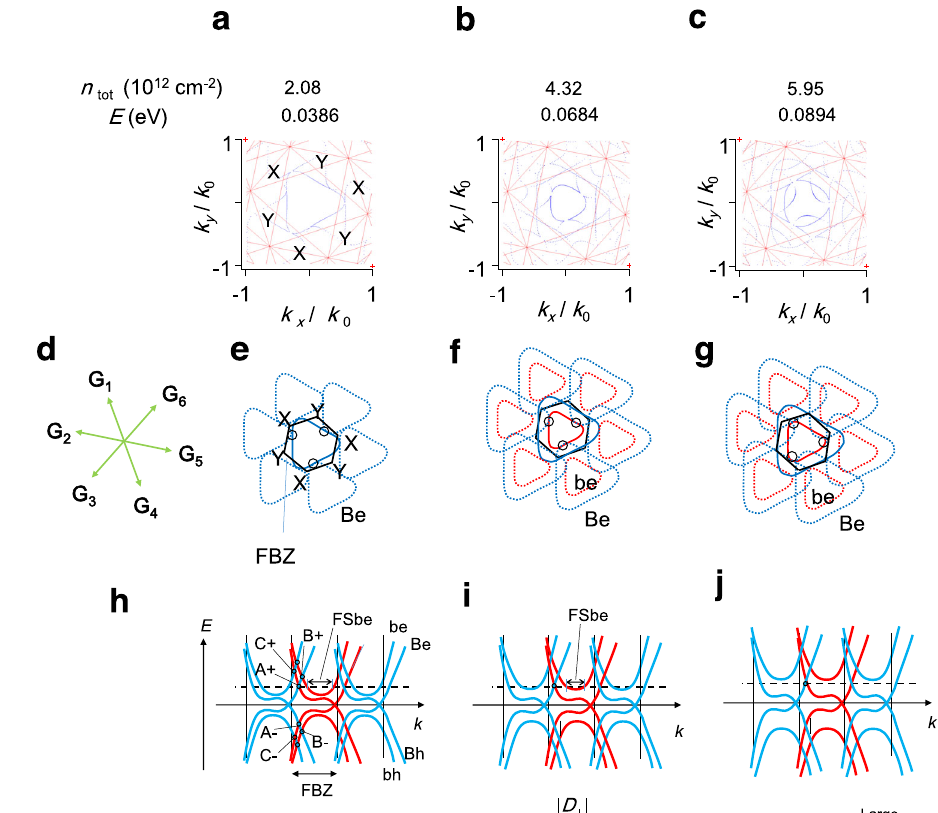
Fig. 3 Topological transition of Fermi surface. Energy contours of the numerically calculated dispersion relation for a E = 0.0386 eV ð n ¼ 2 : 08 ´ 10 12 cm (cid:3) 2 Þ , b E = 0.0684 eV ð n ¼ 4 : 32 ´ 10 12 cm (cid:3) 2 Þ and c E = 0.0894 eV ð n ¼ 5 : 95 ´ 10 12 cm (cid:3) 2 Þ . For all the cases, (cid:5) (cid:5) tot tot tot (cid:5) (cid:5) ¼ 3 : 2 ´ 10 (cid:3) 7 cm (cid:3) 2 As. Hexagon XYXYXY is the fi rst Brillouin zone of the superlattice potential. For a weak potential, the energy gap does not open on D ? the Brillouin zone boundary. d G 1 -G 6 are reciprocal vectors of the superlattice. Panels e – g are schematic illustrations for a – c , respectively. The energy gap opens at the point where the Fermi surfaces in a different Brillouin zone are overlapped (shown by circles). This results in a topological transition of the Fermi surface. Panel e shows the case of overlapping of Be with itself. Panels f and g show different cases of overlapping of be and Be. Panels h – j show schematic illustration of dispersion relations for different j D ? j in the extended zone scheme. Energy gaps open at the points of band crossings where Fermi surfaces separated by a reciprocal vector are overlapped (shown by the open circles). This results in resistivity peaks when the chemical potential is swept. At the chemical potential where A + appears (dashed line), there are two electron bands for D ? ¼ 0 (panel h ). With increasing j D ? j , the difference in energy between the bottoms of Be and be increases. Accordingly, the carrier density decreases, as shown by the size of the Fermi surface of be (FSbe) in Panel i . The Fermi surface of be disappears at the critical j D ? j (panel j